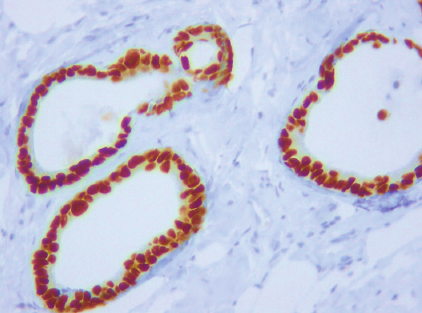
Figure 7: Cytokeratin 20 immunostaining in both cases shows positive cytoplasmic staining in metastatic colonic glands (200x magnification).